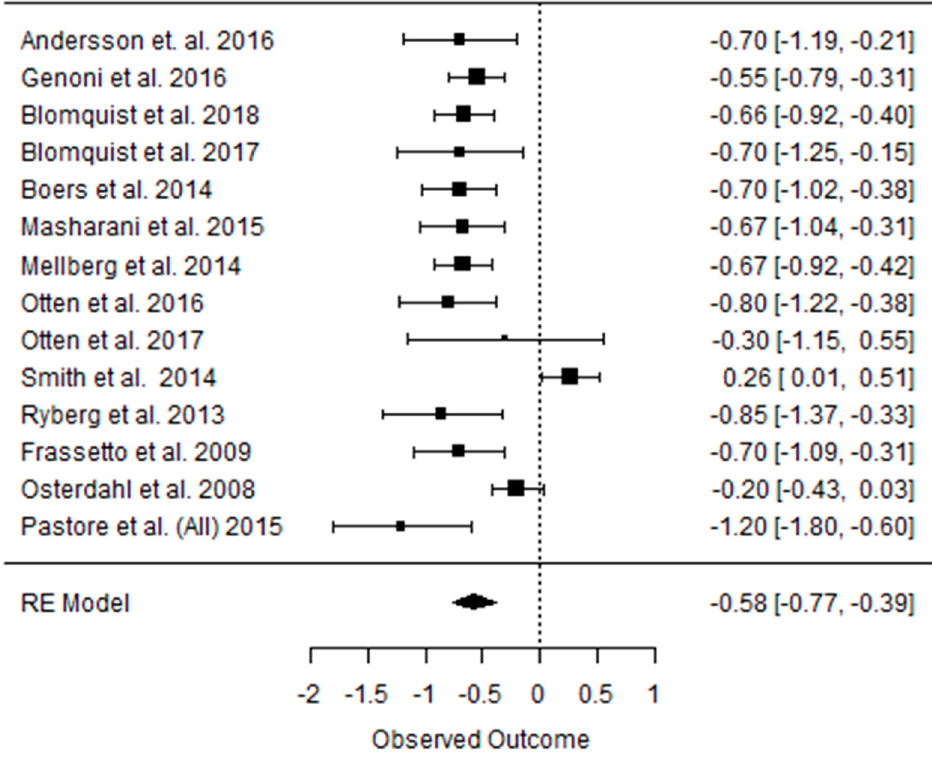
Figure A14. Forest plot of the effect of a PDs on TC in the short term (weighted mean difference).